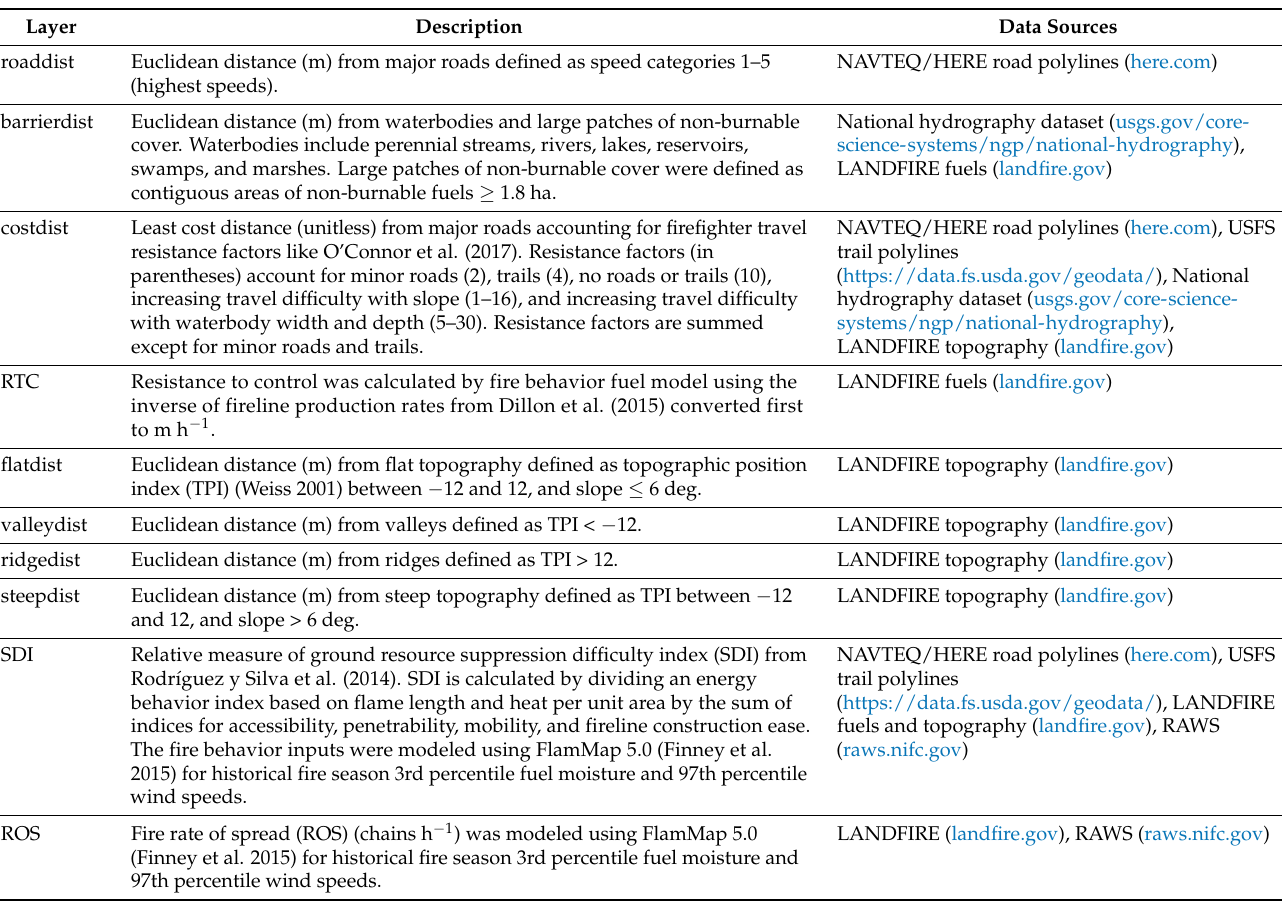
Table A1. Summary of methods used to generate the predictor variable raster layers used in the PCL analysis. Layer Description Data Sources roaddist Euclidean distance (m) from major roads defined as speed categories 1–5 (highest speeds).